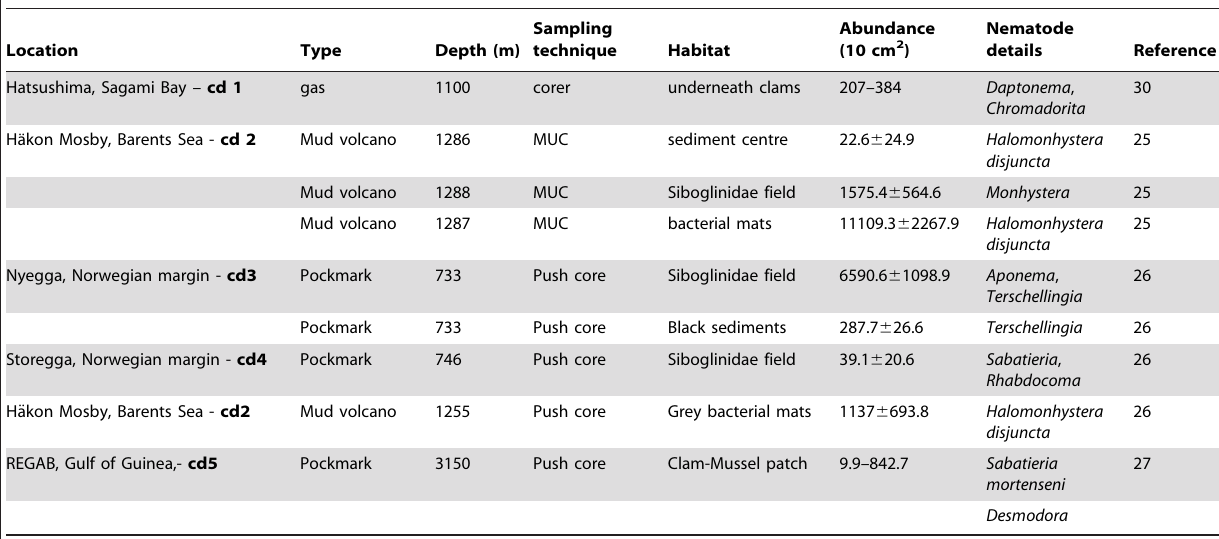
Table 2. Nematodes at deep cold